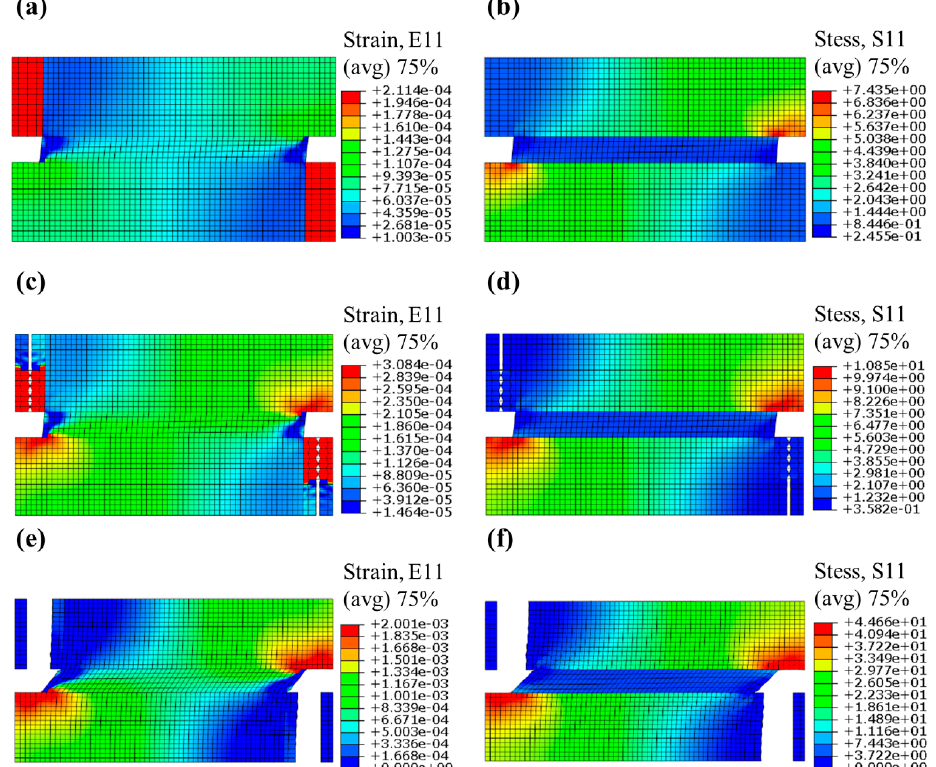
Figure 9. ( a , c , e ) strain and ( b , d , f ) stress contour figures of the deformed FEM model under displacement load. ( a , b ) are at phase “0”, ( e , f ) are at phase “1” and “b” “c” are during the Region 5 breaking process.